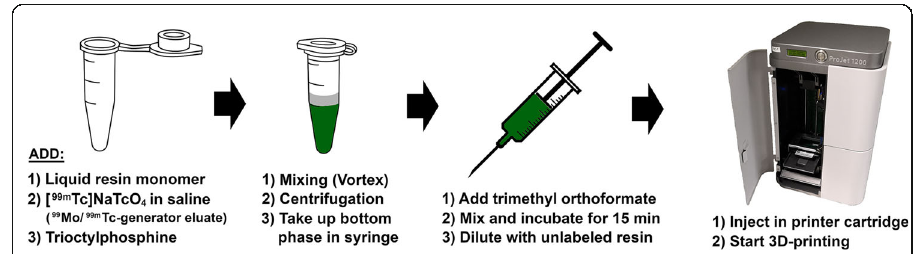
Fig. 1 Schematic overview of the procedure for preparation of the 99m Tc-spiked liquid resin